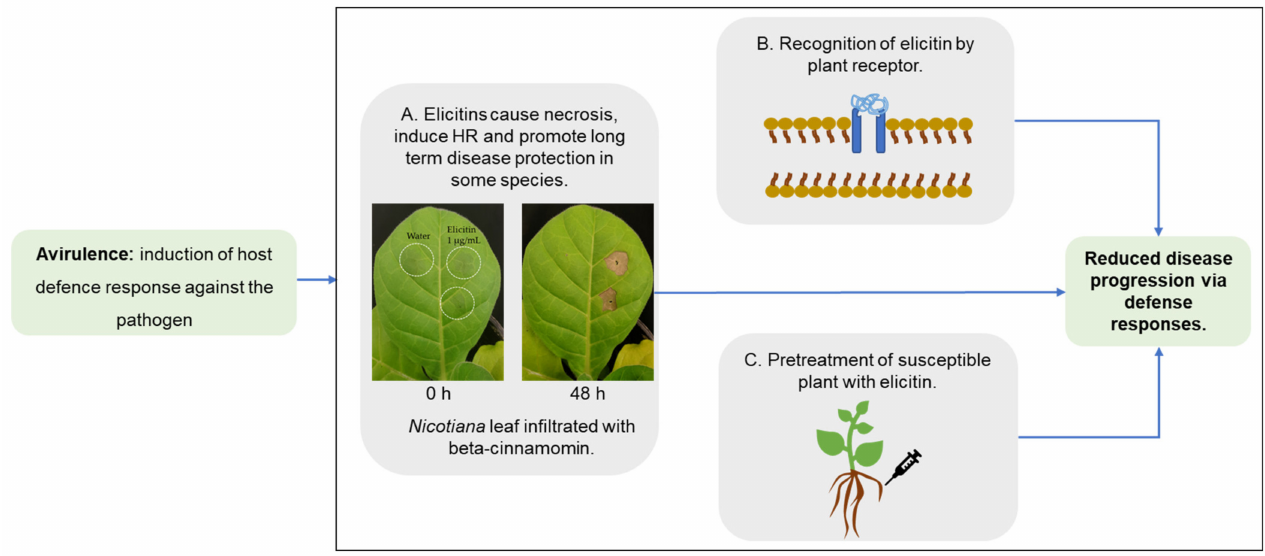
Figure 3. Summary of studies that support the role of elicitins as an avirulence factor. ( A ) The hallmark response